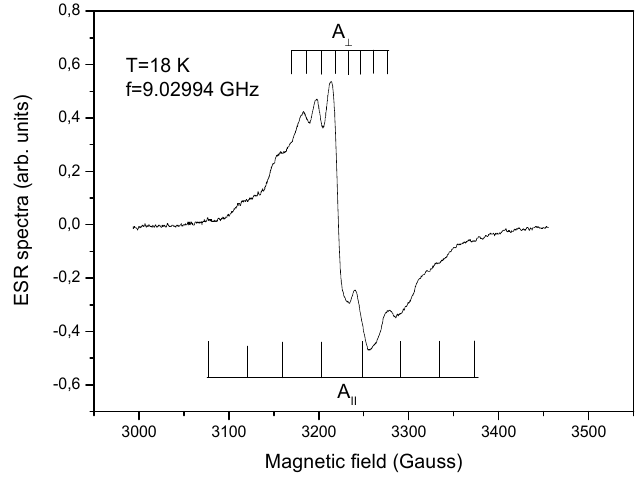
Figure 6. The EPR spectrum of powder [V(L sq1 )(HL ox )] sample.